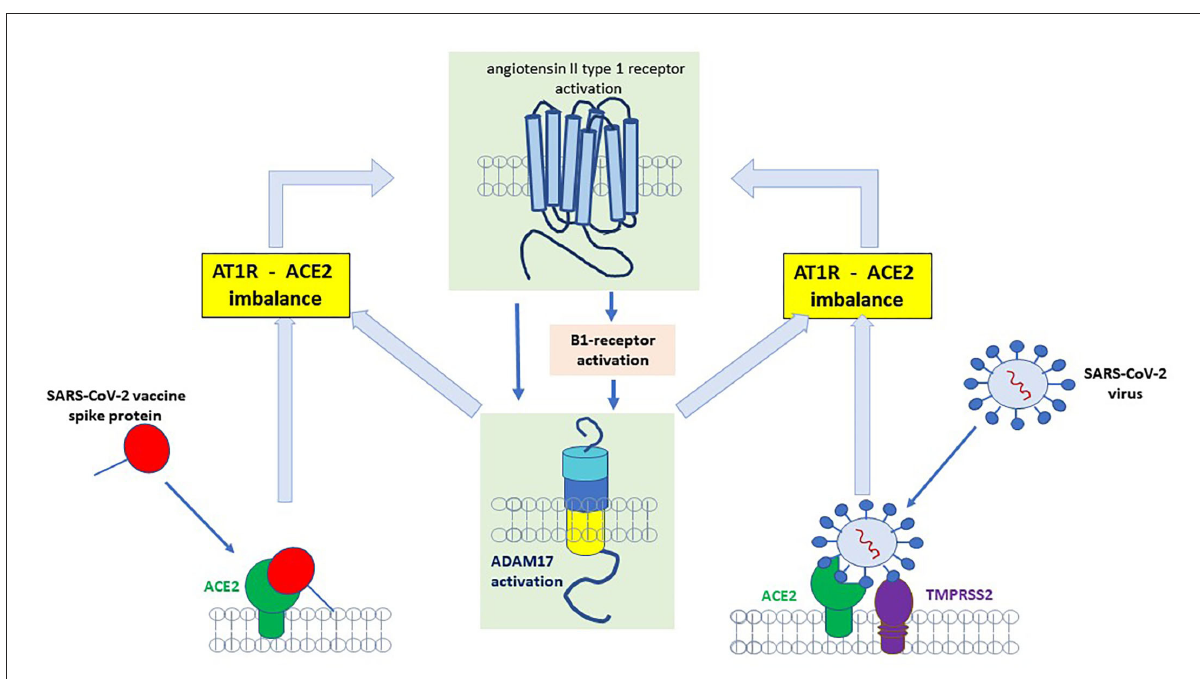
FIGURE3 Binding of SARS-CoV-2 spike protein to angiotensin-converting enzyme 2 (ACE2) receptor results in the upregulation/activation of angiotensin II type 1 receptor (AT1)- and bradykinin B1 receptor (B1)-receptor which further induces a disintegrin and metalloprotease (ADAM)17 upregulation. ADAM17 is a sheddase for ACE2 and an increase in ADAM17 results in more degradation of ACE2. Less ACE2 will increase B1R (because degradation of [des-Arg9]-bradykinin (DABK) by ACE2 will decrease and more DABK is available for binding to B1R).